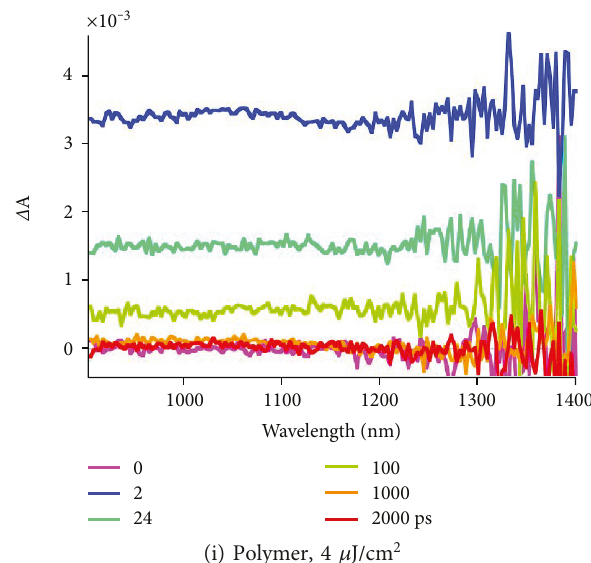
Figure 3: Displayed are selected fs-TA spectra of thin fi lms at various delay times and at di ff erent laser powers: (a, b, c) FINE blends (using ; (g, h, i) pristine PDPP polymer fi lms. Delay times are indicated. cosolvents ODCB/DIO); (d, e, f) COARSE blends obtained from CHCl 3 Excitation was performed at 530 nm. Note: if we go from (a) to (b) to (c) (or from (d) to (e) to (f) or from (g) to (h) to (i)) the relative amount of ultrafast triplet formation (1100nm band) by singlet fi ssion is reduced at early times; if we go from (g) to (d) to (a) (or from (h) to (e) to (b) or form (i) to (f) to (c)) the relative amount of ultrafast charge generation is increased (1350nm